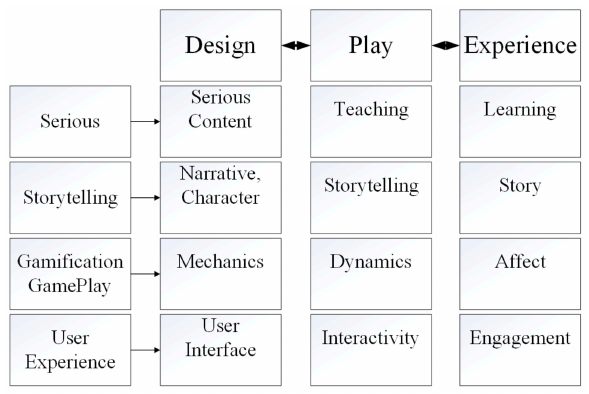
Figure 1. Design, Play and Experience (DPE)